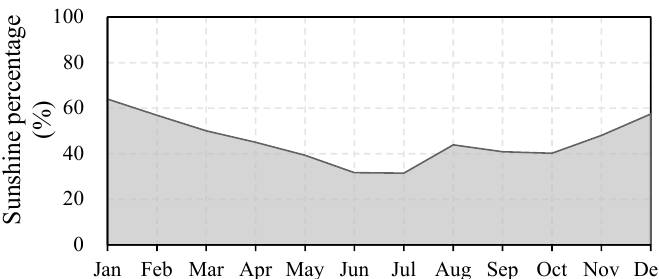
Figure 3. The monthly average percentage of maximum possible sunshine at Mito WMO (World Meteorological Organization) weather station located near Lake Kasumigaura during 2002–2012.